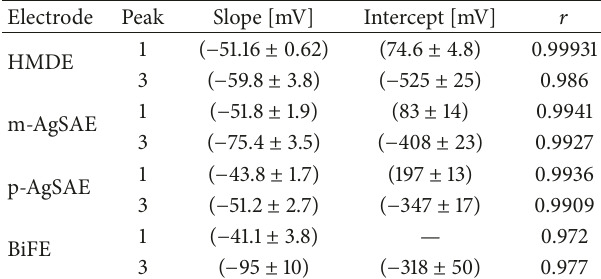
= +200 mV, 𝐸 fin = − 1300 mV, V in